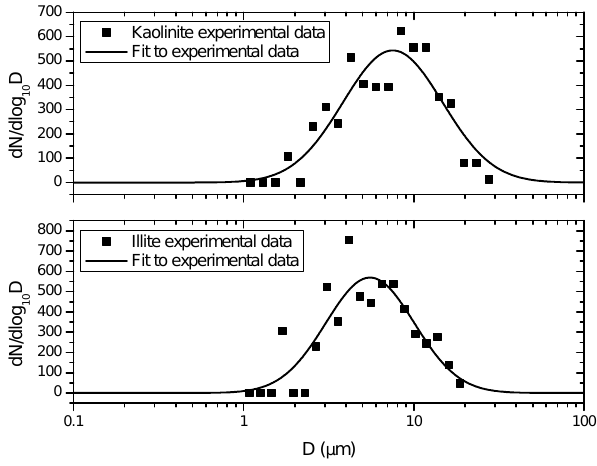
Fig. 2. Number distributions measured using the optical micro- scope. N represents the cumulative number distribution function and D represents the diameter. The experimental data were fit to a log-normal distribution function. Based on fits to the data, the mean geometric diameter (cid:0) ¯ D g (cid:1) and geometric standard deviation (cid:0) σ g (cid:1) in the experiments were 7.52µm and 1.96 for kaolinite and 5.53µm and 1.82 for